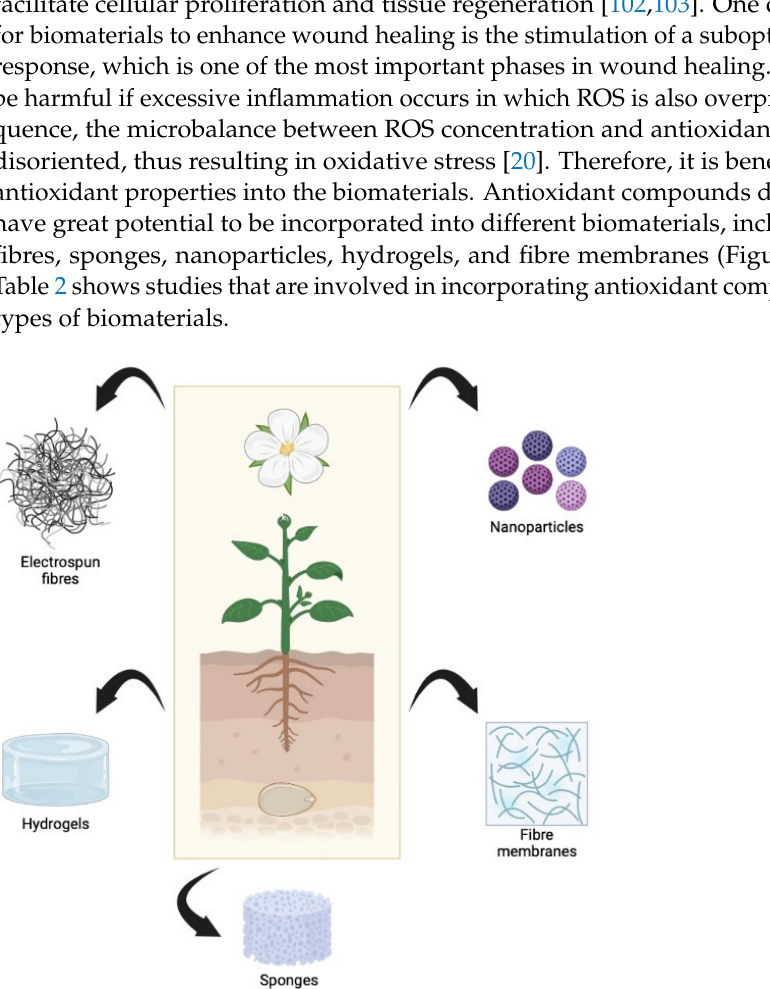
Figure 4. Different types of materials from plant-derived antioxidant compounds. The idea of the figure is adapted from [104]. figure is adapted from